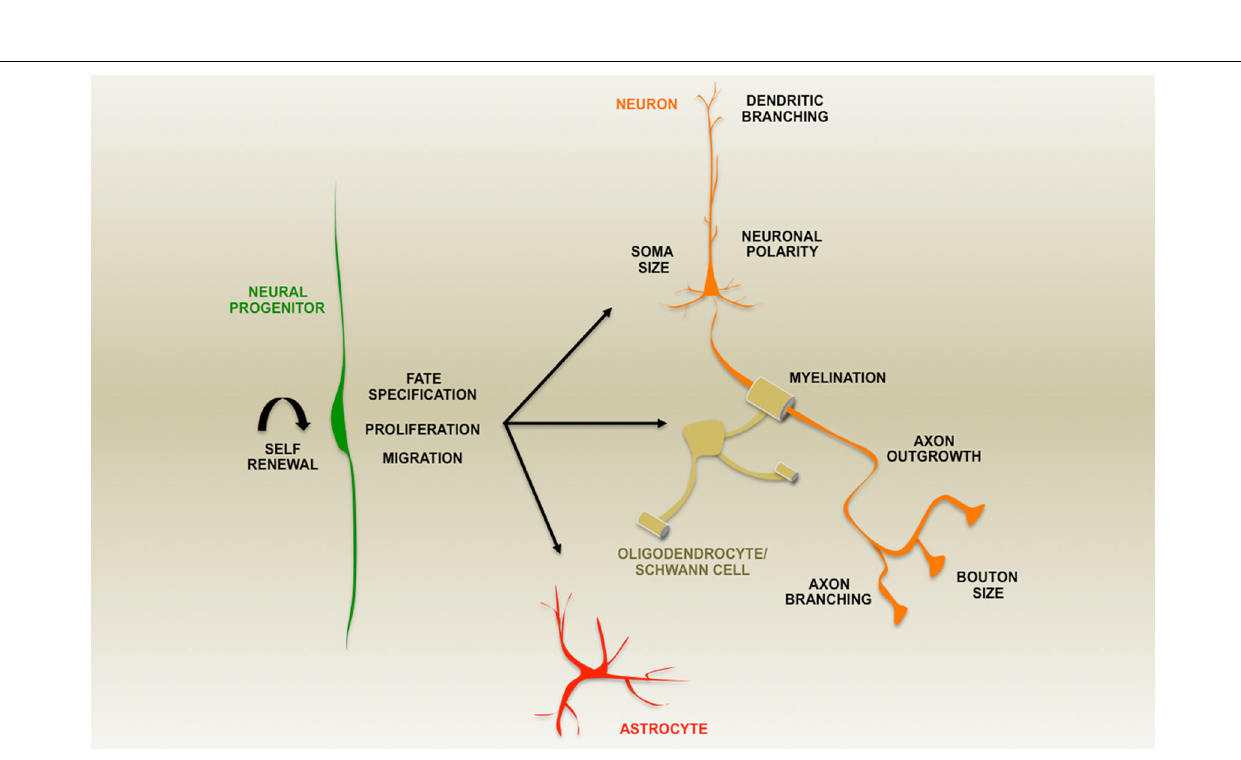
Frontiers in Molecular